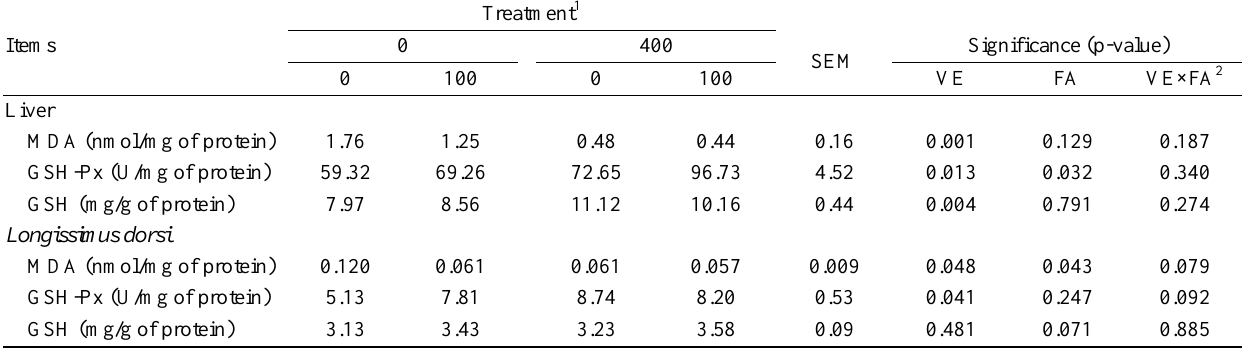
SEM, pooled standard error of the means; MDA, malondialdehyde; GSH-Px, glutathione peroxidase; GSH, glutathione. 1 A 2×2 factorial arrangement with 2 supplemental levels of VE (0 or 400 mg/kg α-tocopheryl acetate) and 2 supplemental levels of FA (0 or 100 mg/kg ferulic acid) in basal diets. 2 VE×FA, the interaction between VE and FA.